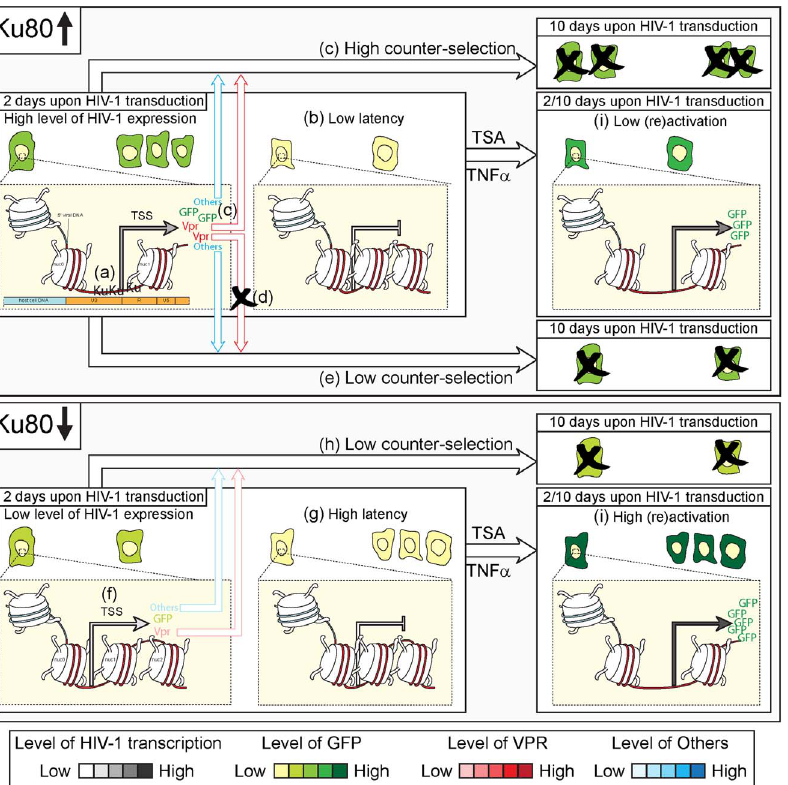
Figure 7. Hypothetical role of Ku on HIV-1 expression and latency at early- and mid-time upon transduction. When expressed at a normal level (as in Ku80-proficient cells), Ku stimulates the early expression of human immunodeficiency virus type 1 (HIV-1) by a direct binding to long terminal repeat (LTR) ( a ), a condition that is accompanied by a low level of viral latency ( b ) and that in turn leads to a high counter-selection of transduced cells over time for the expression of toxic viral proteins including Vpr ( c ). In line with this, the absence of Vpr (as by transducing the HIV-1 vector XCD3 vpr - ) ( d ) decreases the level of cell death and/or counter-selection over time ( e ). On the contrary, a low level of Ku (as in Ku80 + / 2 cells or in WT cells transfected with Ku-depleting siRNAs) negatively affects the expression of HIV-1 ( f ), increases the proportion of cells with latent viruses ( g ) and reduces the counter-selection phenomenon ( h ). Accordingly, the reactivation of HIV-1 upon trichostatin A (TSA)- or Tumor Necrosis Factor a (TNF a )-treatment at 2 or 10 days after transduction is more efficient in Ku80 + / 2 cells that in their WT counterparts ( i ). Hence, we suggest that the depletion of Ku may favor the appearance/maintenance of cells harboring integrated proviruses in a latent and readily (re-)activatable state starting from the early phases from HIV-1